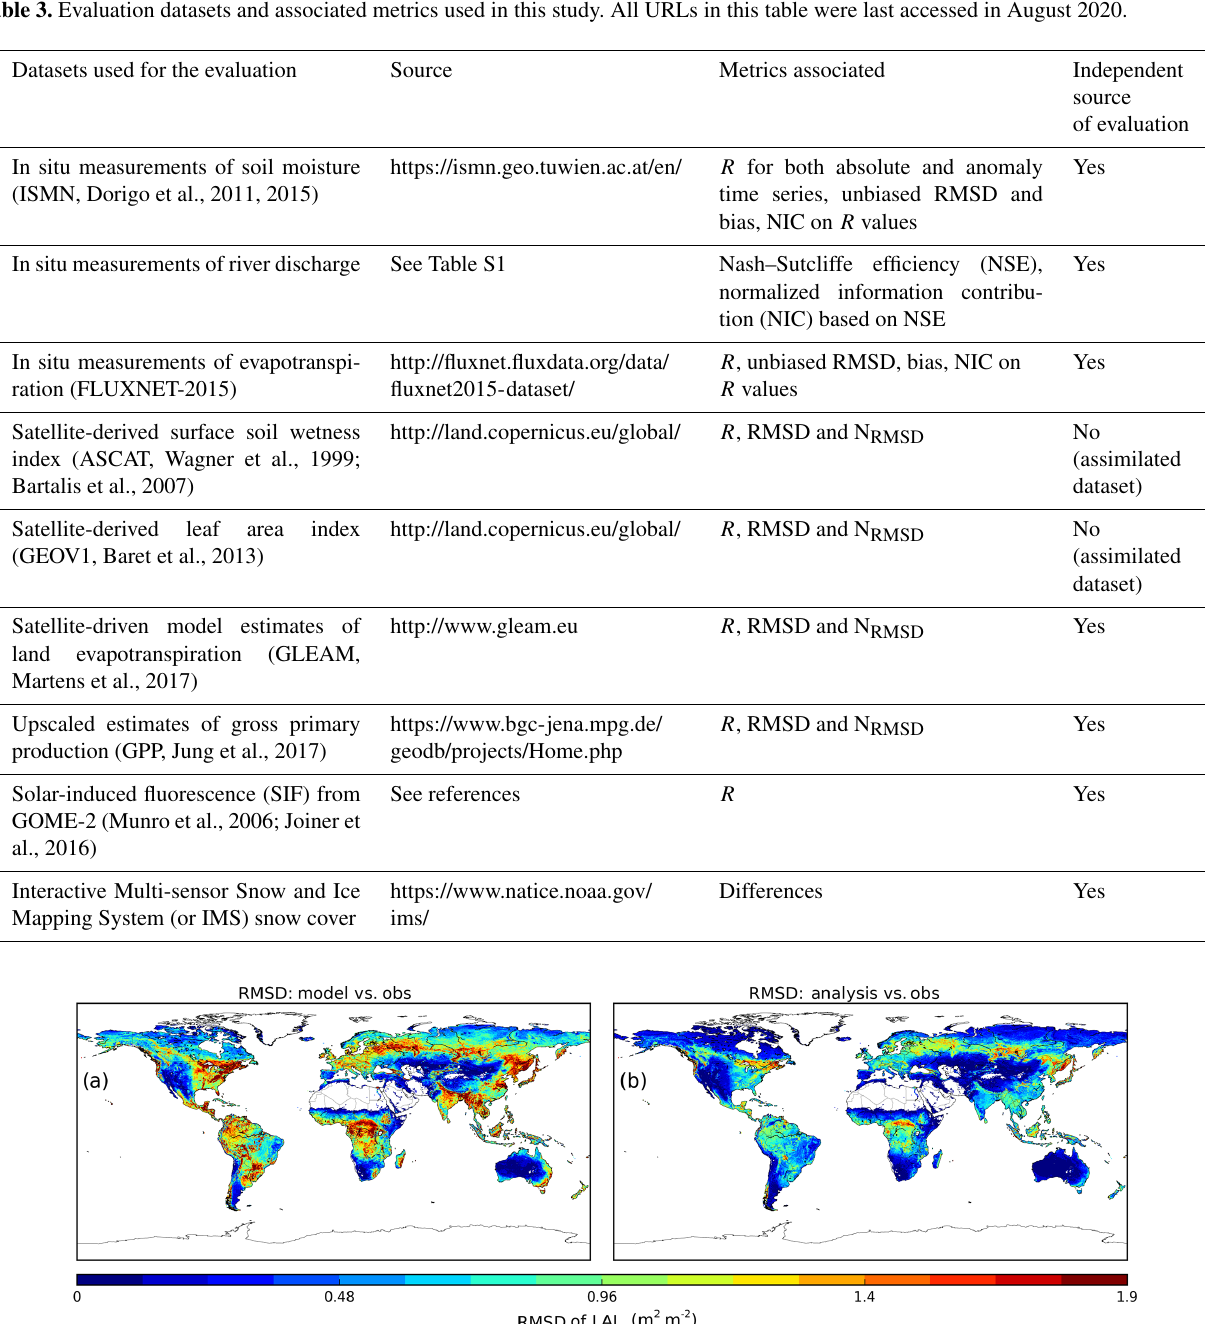
Figure 3. RMSD values between observed leaf area index (LAI) and LDAS_ERA5 (a) before assimilation and (b) after assimilation of surface soil moisture (SSM) and